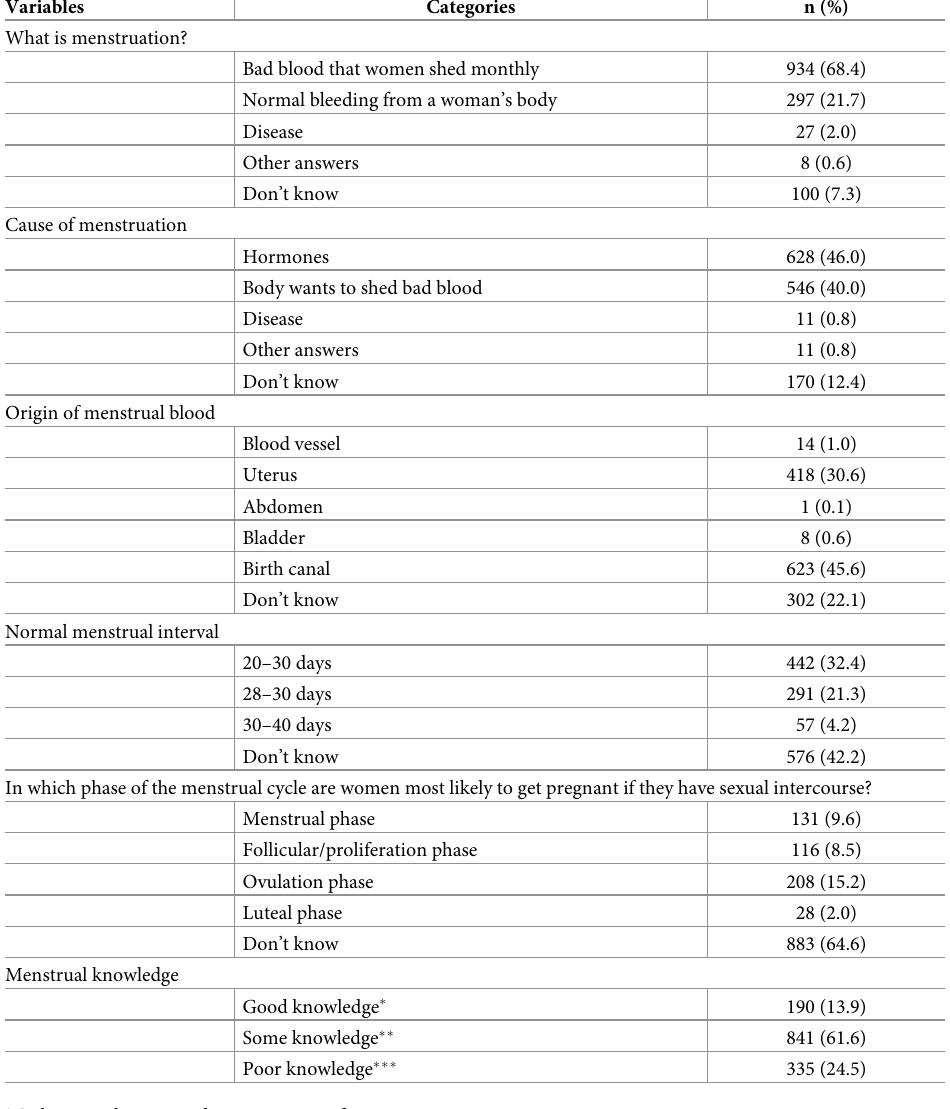
Table 3. Knowledge of menstruation among secondary school girls, Luang Prabang Province (N =